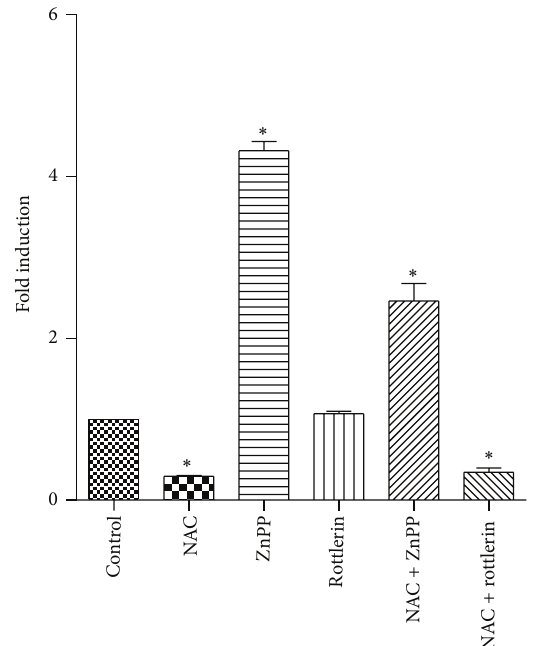
Figure 8: Effect of NAC on ZnPP- or rottlerin-induction of HO-1. PC-3 cells were treated with nothing (control); 10mM NAC (5h); 10 𝜇 M ZnPP (5h); 2 𝜇 M rottlerin (5h); 10mM NAC (1h pretreat- ment) plus 10 𝜇 M ZnPP (5h); or 10mM NAC (1h pretreatment) plus 2 𝜇 M rottlerin (5h). Relative HO-1mRNA levels were determined by real-time PCR as described in Section 2. Results were expressed as “Fold Induction” over control. 𝑁 = 3 ; ∗ 𝑃 < 0.05 compared with